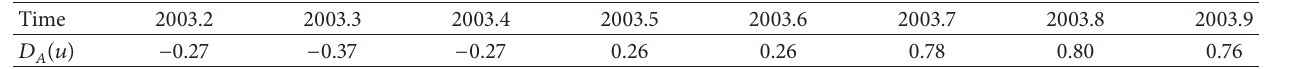
Table 6: Relative differences for Contract F